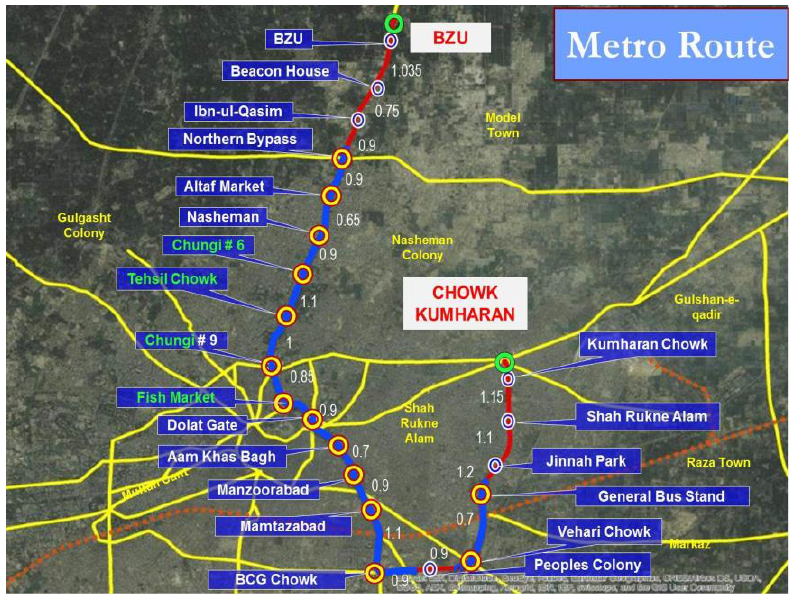
Figure 3. Route Map of BRT Multan [28].